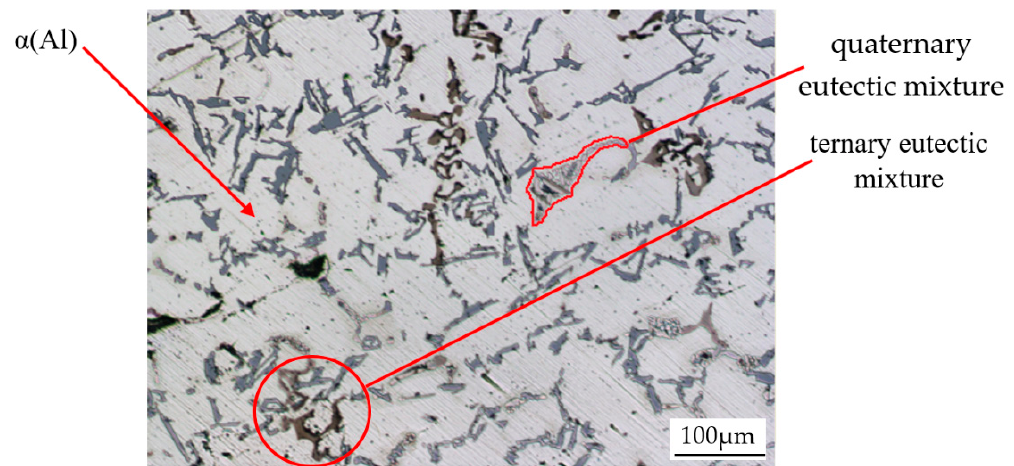
Figure 2. Microstructure of the base Al-Si alloy in the casting from the shell sand probe: α , α + Al 15 (Fe,Mn) 3 Si 2 + β , α + Al 2 Cu + AlSiCuFeMnMgNi + β .